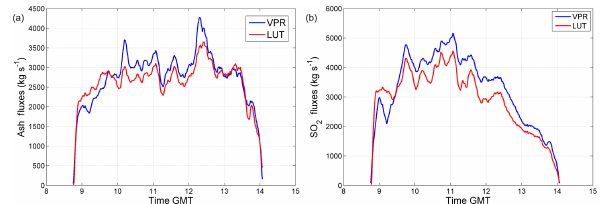
Figure 7. Ash (a) and SO 2 (b) fluxes at the craters calculated with the two procedures, LUT and VPR (Merucci et al.,